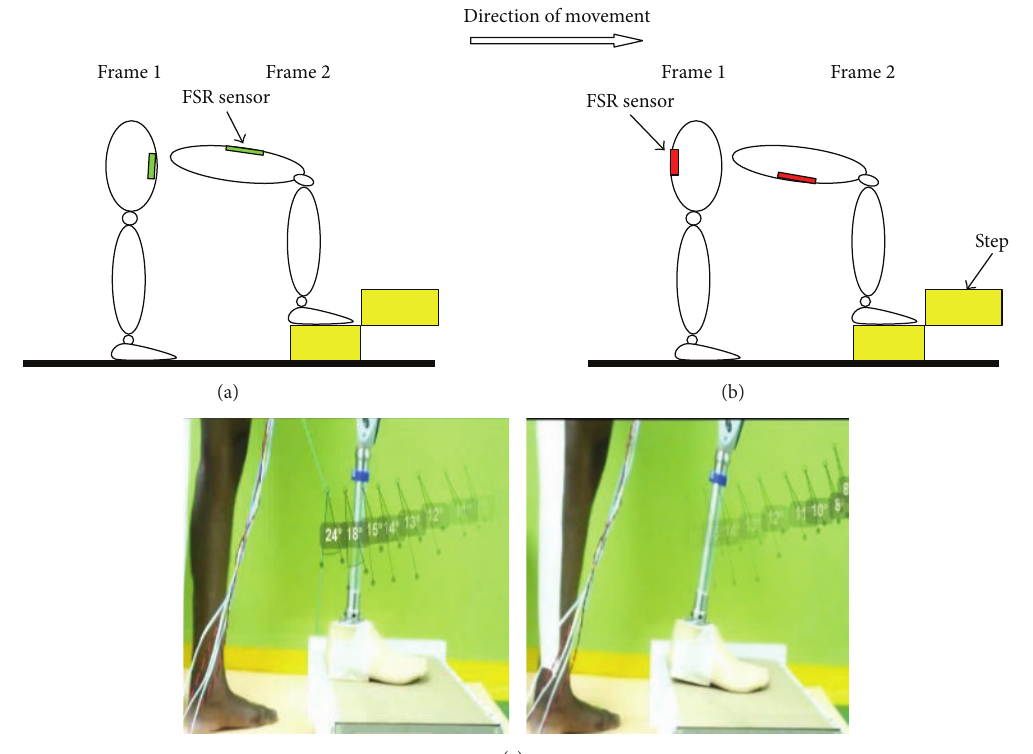
Figure 5: (a) Anterior FSR placement during stair ascent; (b) posterior FSR placement during stair ascent; and (c) the individual performing stair ascent while wearing the FSR instrumented socket.